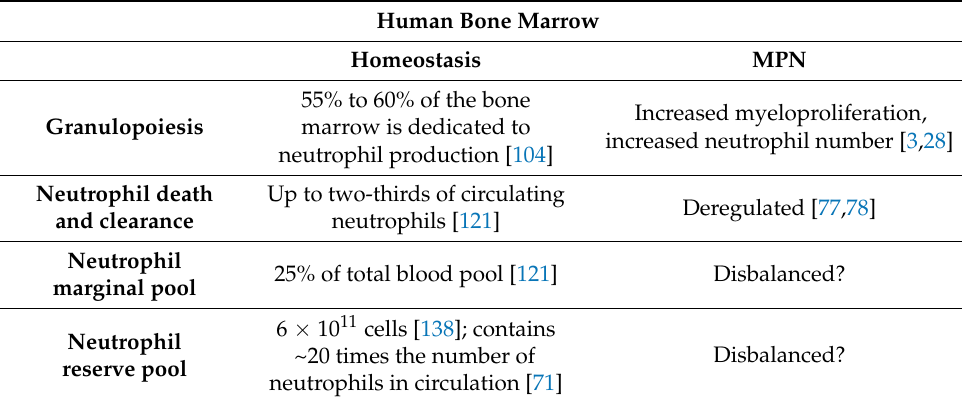
Table 1. The bone marrow neutrophil compartments in